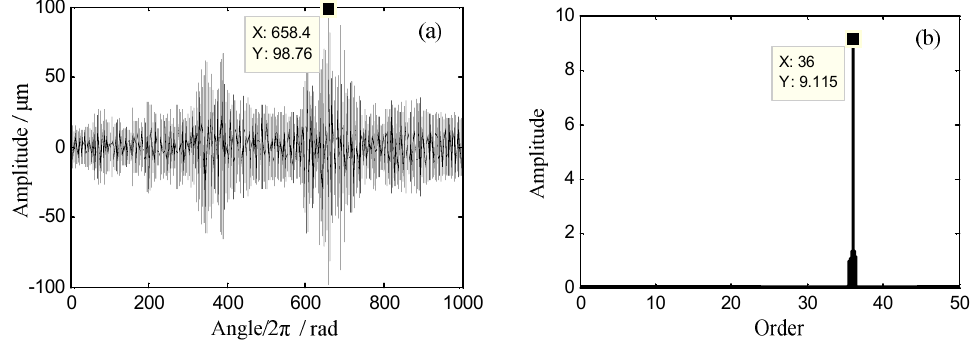
Figure 25. ( a )The angular-domain reconstruction signal and ( b ) its order spectrum of the 11th blade.